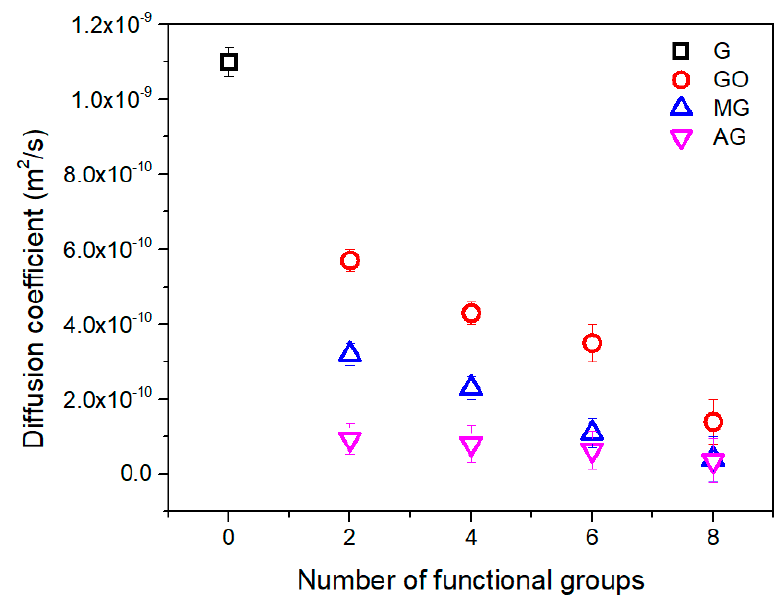
Figure 7. Radial distribution function for graphene-PAO molecules at 300 K and 0.1 MPa from EMD simulations.